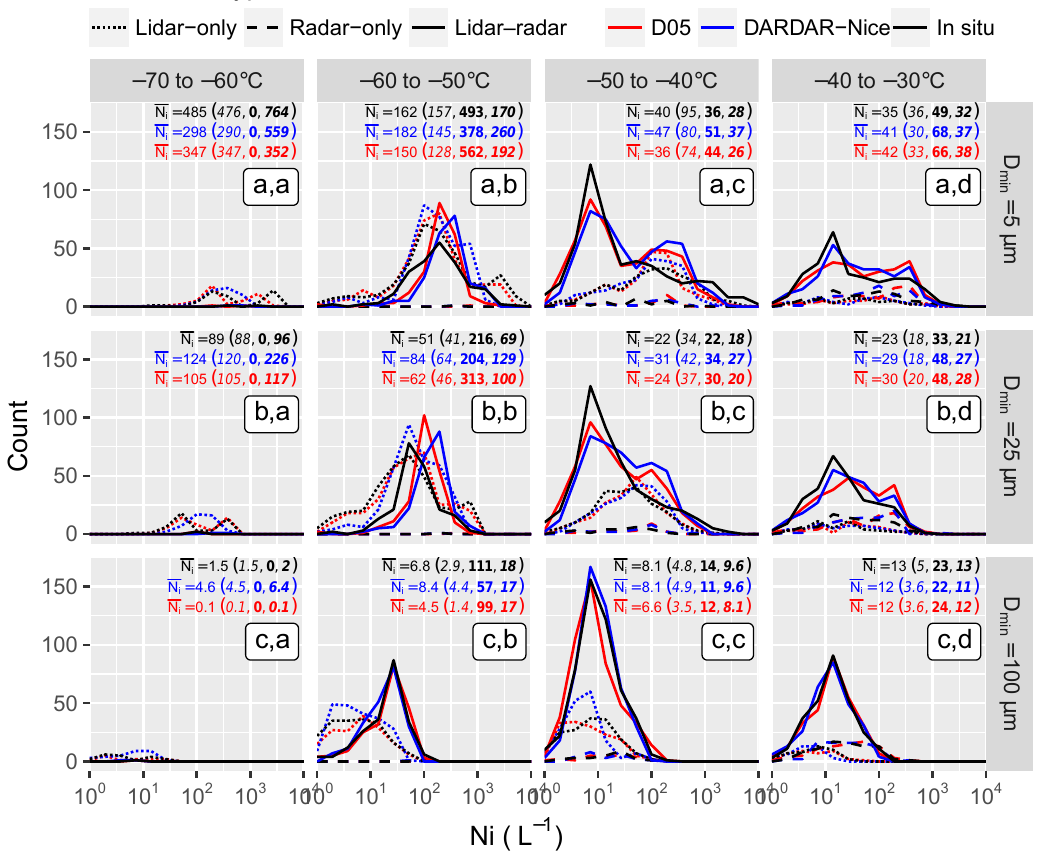
Figure 4. Histograms of N i measured during SPARTICUS (black), theoretically estimated by D05 (red) and retrieved by DARDAR-Nice (blue). Plain, dotted and dashed lines indicate that DARDAR retrievals were obtained using lidar-only, radar-only and lidar–radar, respec- tively. Panels indicate the temperature and integration threshold, in a similar fashion to Fig. 2. Geometric means of N i (represented in per liter) are shown in each panel for 2D-S, DARDAR-Nice and D05. The overall mean is indicated first, followed in brackets by values for the lidar-only (italic), radar-only (bold) and lidar–radar (bold-italic)